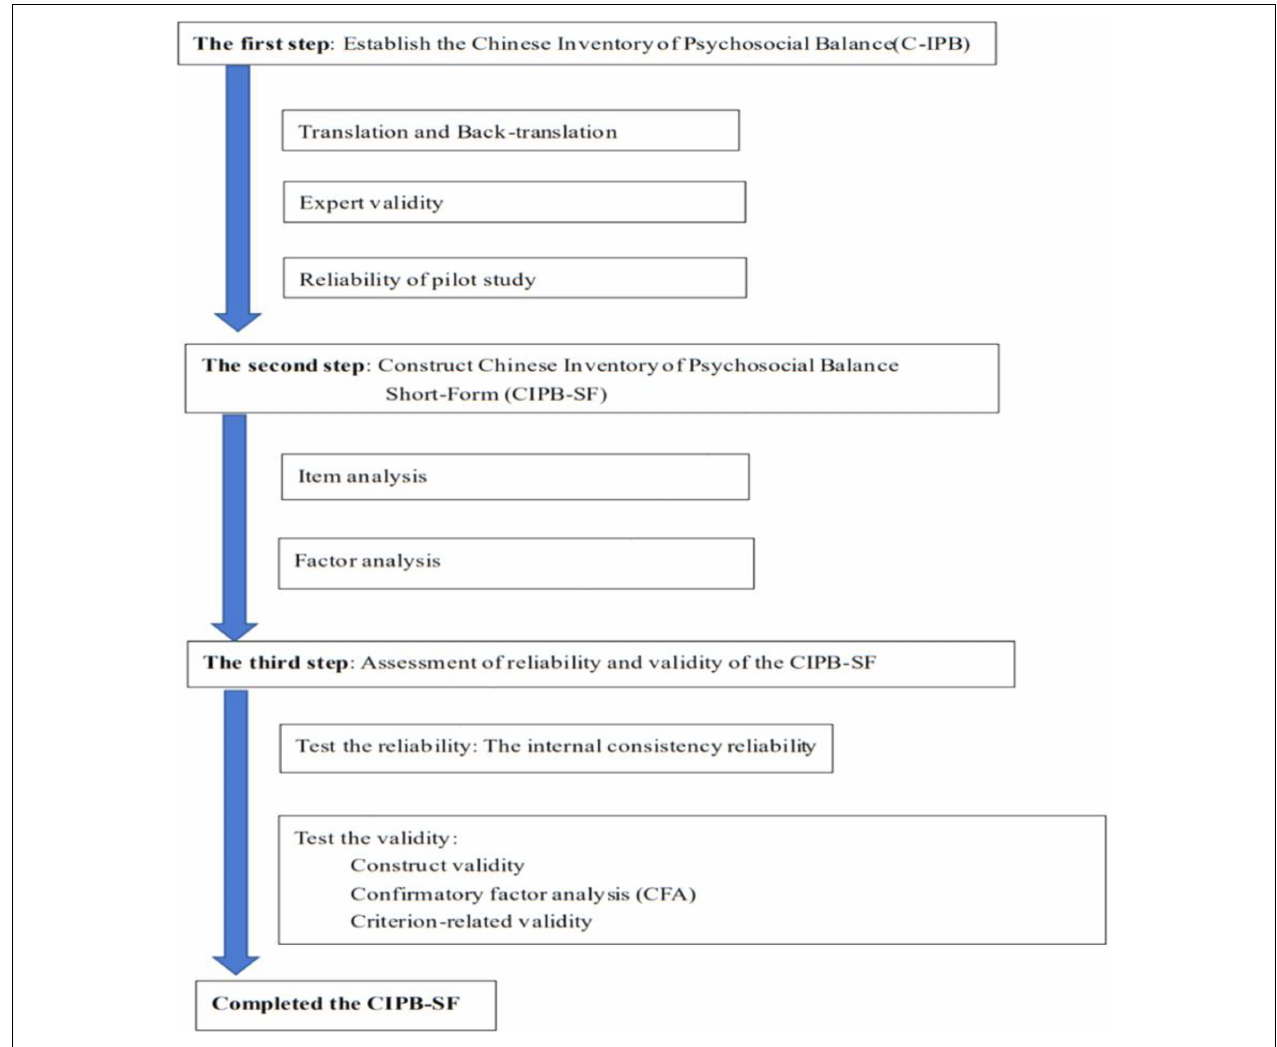
FIGURE 1 | Development and establishing the